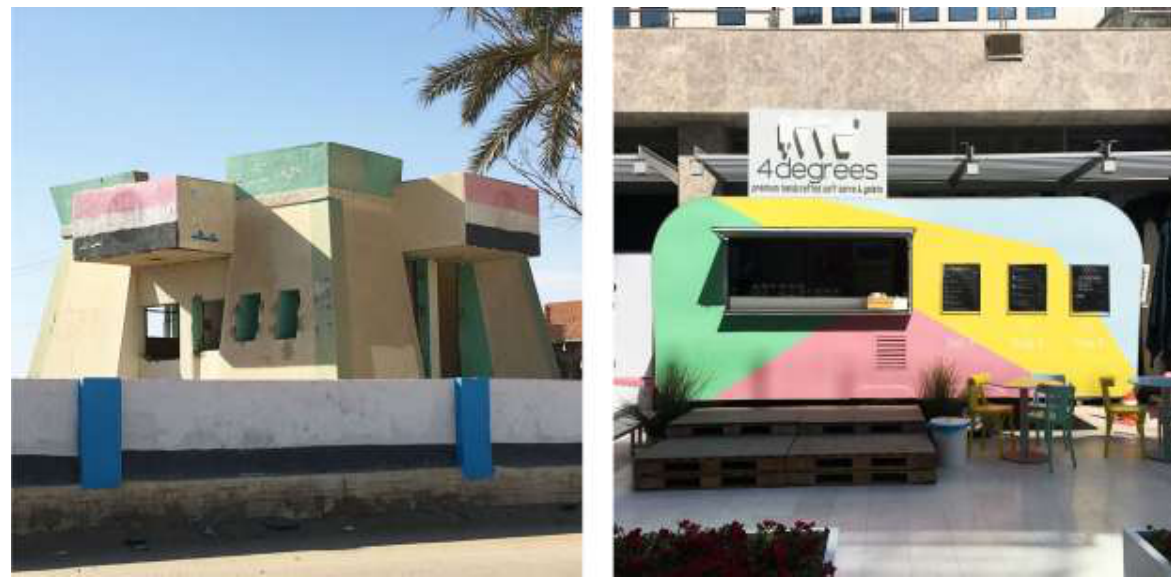
Figure 6 High contrasts yet similar